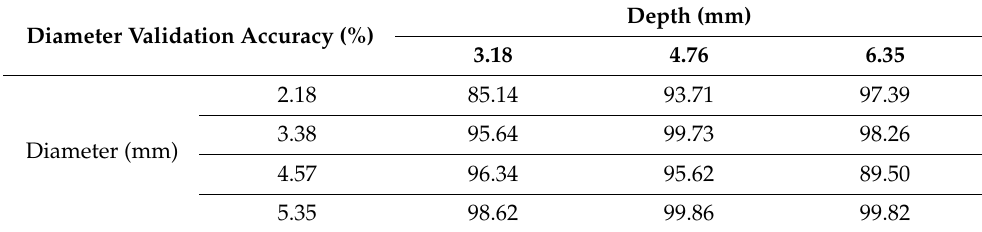
Table 11. Detailed validation accuracy of MIMO ANN model for diameter prediction.